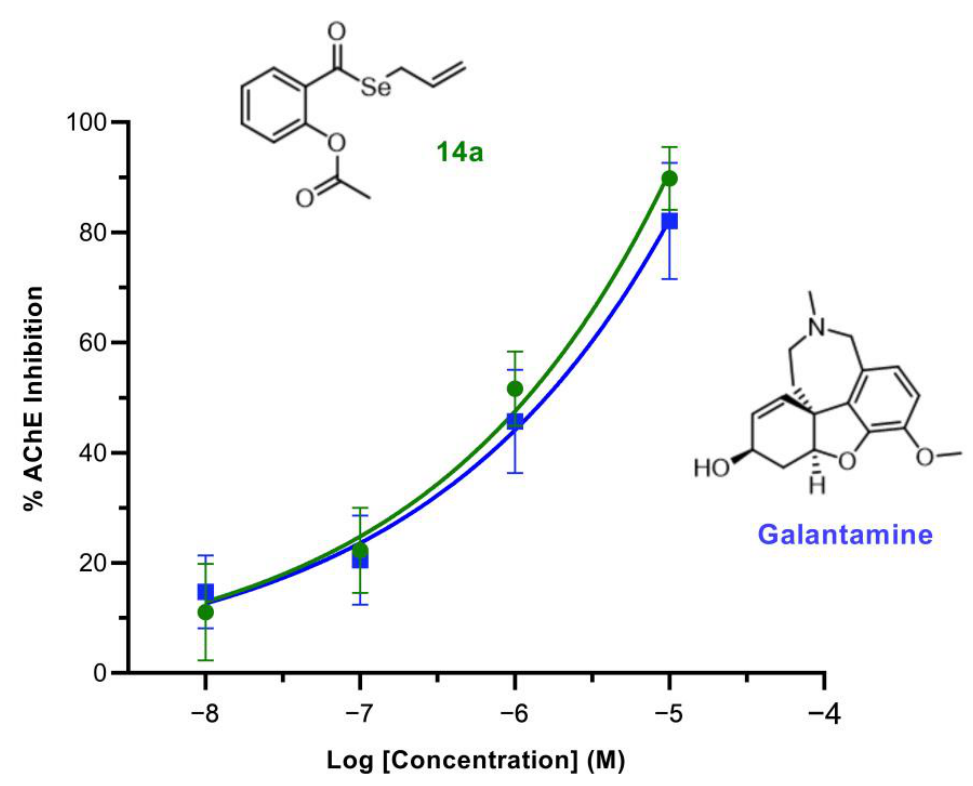
Figure 6. Dose-inhibition curve for AChE inhibition by compound 14a (green) compared to galan- tamine (blue).